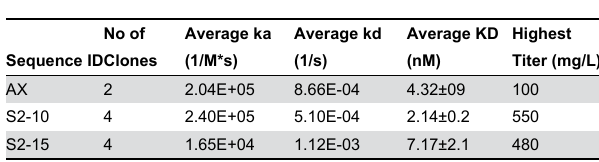
Table 3. Binding Affinities and Titers of anti-PCSK9